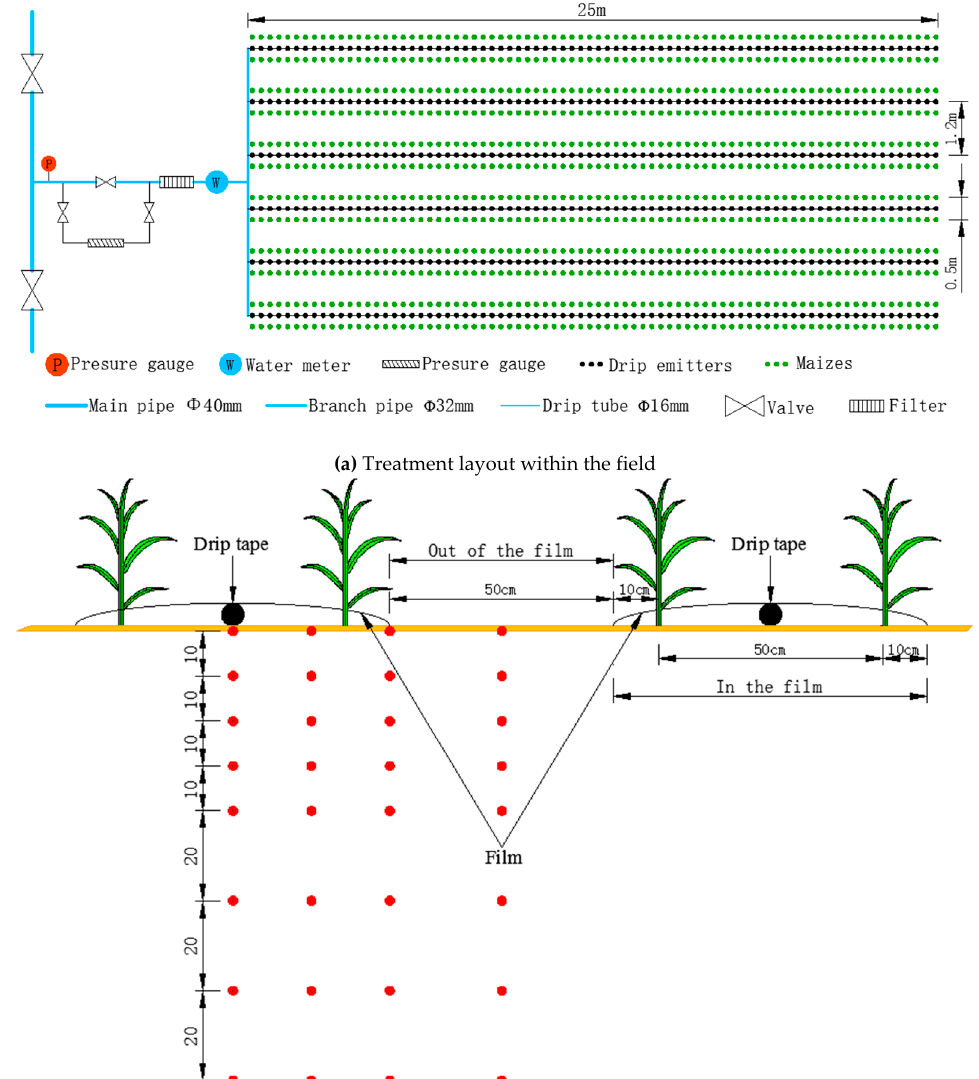
Figure 3. The schematic diagram of cultivation model, sampling and treatment layout. 2.3. Irrigation and Fertilization.